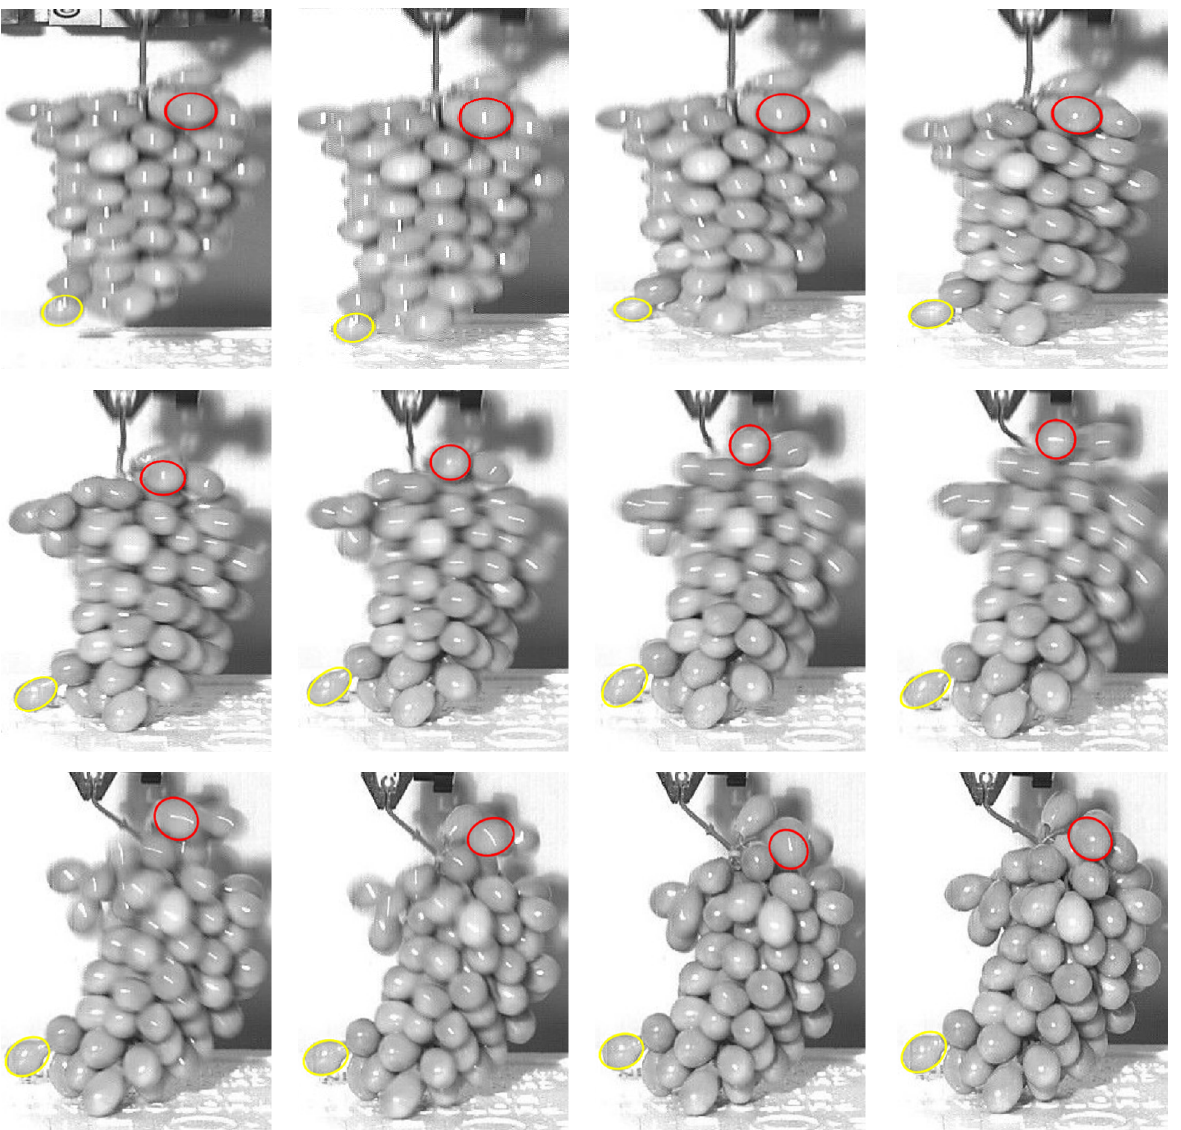
Figure 11. Behavior of berry deflection during robotic placing. Top berry in (red color) and bottom berry (yellow color).